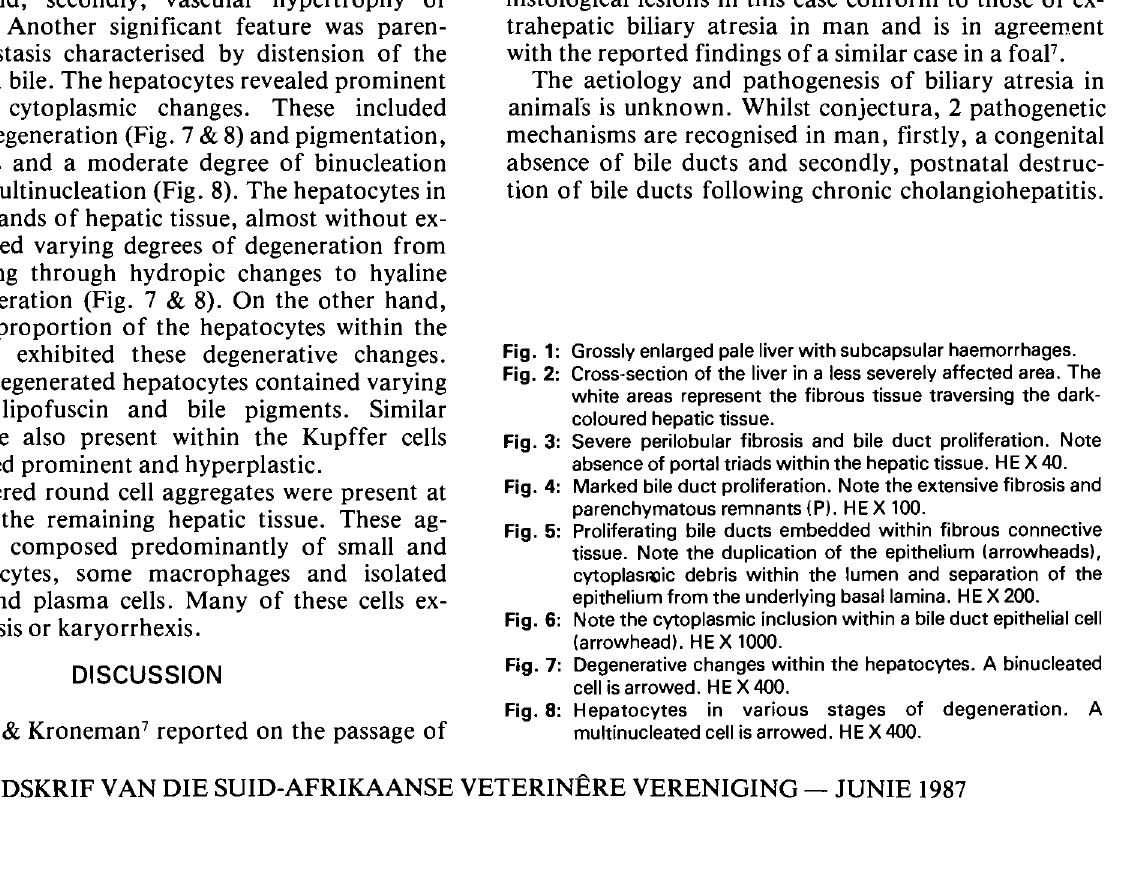
Fig. 1: Grossly enlarged pale liver with subcapsular haemorrhages. Fig. 2: Cross-section of the liver in a less severely affected area. The white areas represent the fibrous tissue traversing the dark coloured hepatic tissue. Fig. 3: Severe perilobular fibrosis and bile duct proliferation. Note absence of portal triads within the hepatic tissue. HE X 40. Fig. 4: Marked bile duct proliferation. Note the extensive fibrosis and parenchymatous remnants (Pl. HE X 100. Fig. 5: Proliferating bile ducts embedded within fibrous connective tissue. Note the duplication of the epithelium (arrowheads), cytoplasltlic debris within the lumen and separation of the epithelium from the underlying basal lamina. HE X 200. Fig. 6: Note the cytoplasmic inclusion within a bile duct epithelial cell (arrowhead). HE X 1000. Fig. 7: Degenerative changes within the hepatocytes. A binucleated cell is arrowed. HE X 400. Fig. 8: Hepatocytes in various stages of degeneration. A multinucleated cell is arrowed. HEX